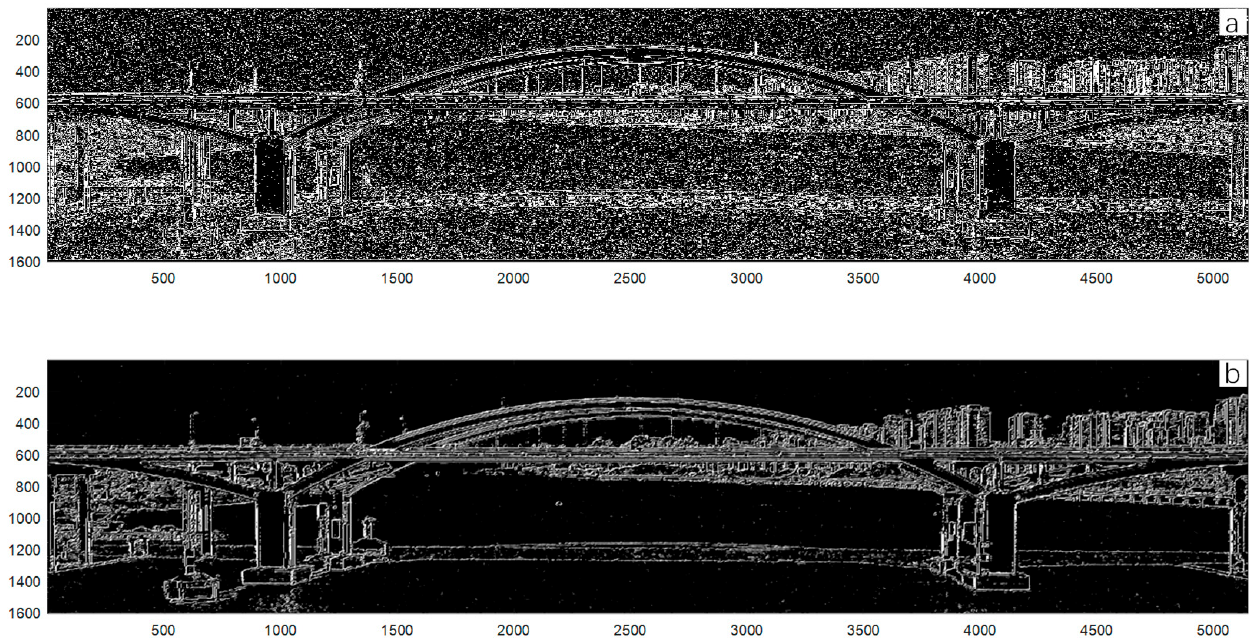
Figure 7. Canny operator edge detection results: ( a ) not denoised; ( b ) denoised.